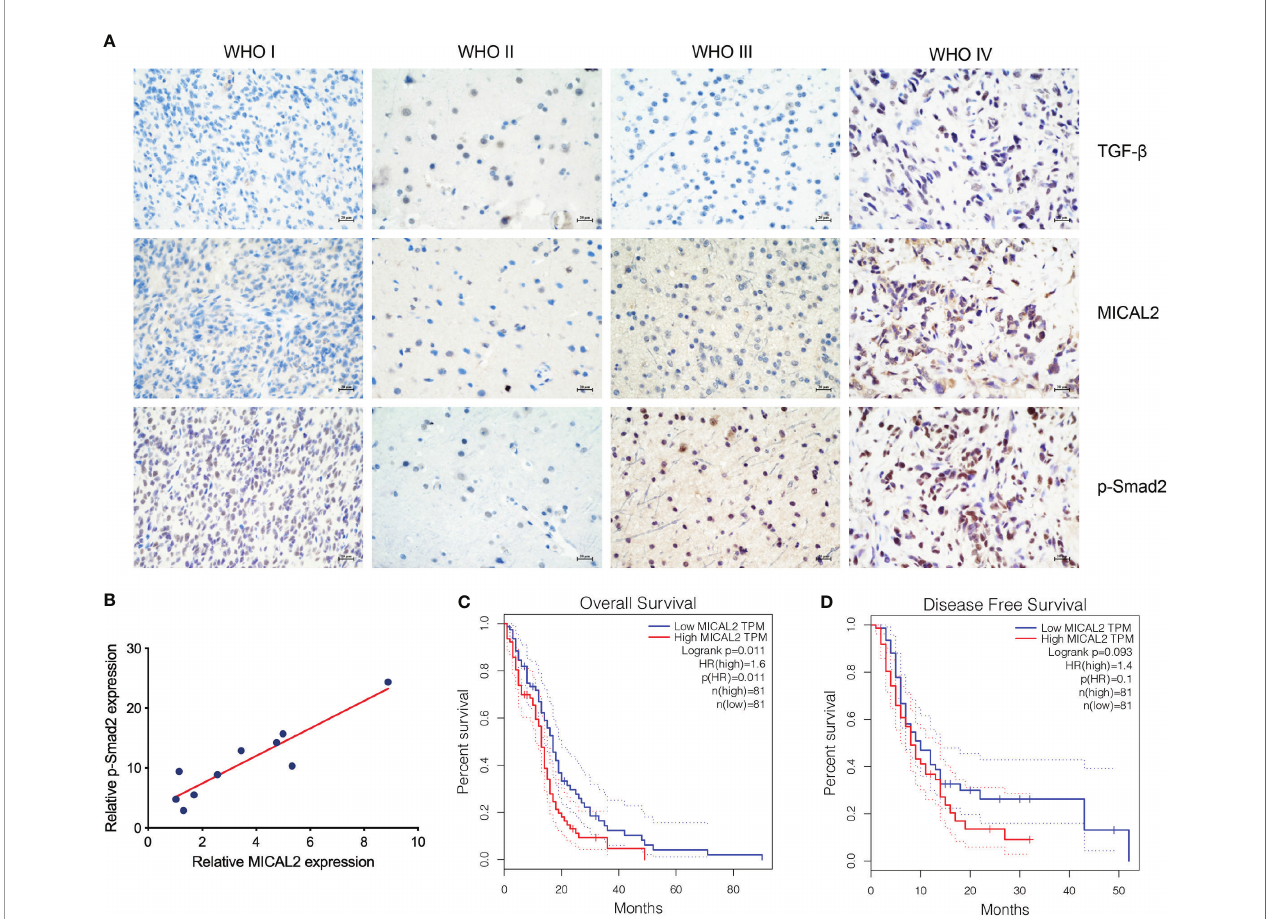
FIGURE 1 | MICAL2, TGF- b , and p-Smad2 expresssion levels are elevated in GBM cells. (A) Immunohistochemical results showed that the expression level of MICAL2, TGF- b , and p-Smad2 are elevated in high-grade gliomas. (B) Regression linear equations fi tted to the relative expression levels of MICAL2 and p-Smad2 in GBM tissues. (C, D) Kaplan-Meier survival analysis in 81 primary GBM cases strati fi ed by MICAL2 expression level indicates that high level of MICAL2 expression was associated with lower OS ( p = 0.011 < 0.05), but there was no signi fi cant difference in DFS between low MICAL2 and high MICAL2 expression levels ( p = 0.093 >